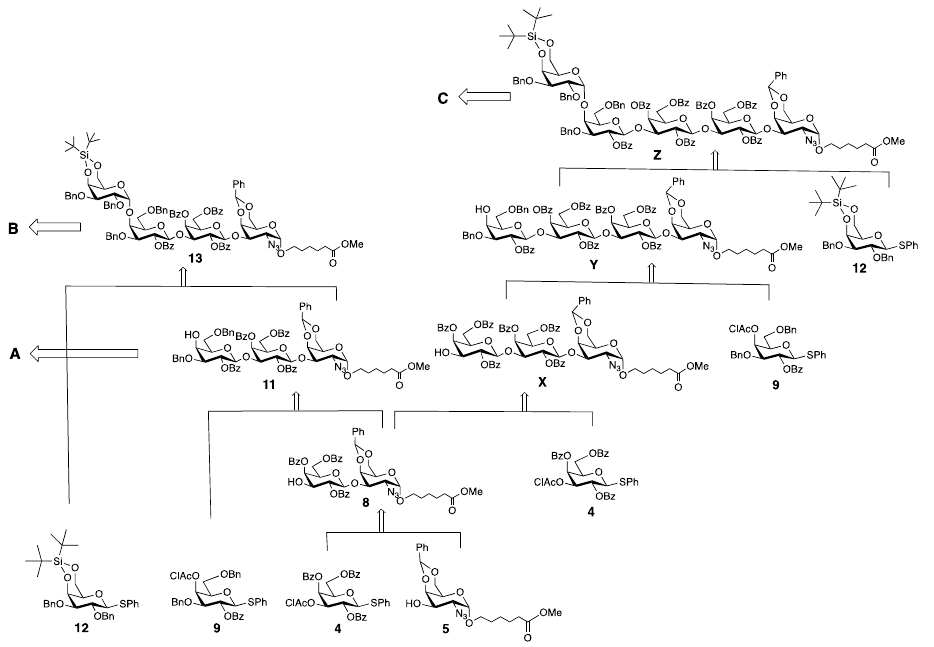
Figure 3. Synthetic strategy of tri-, tetra, and pentasaccharides.